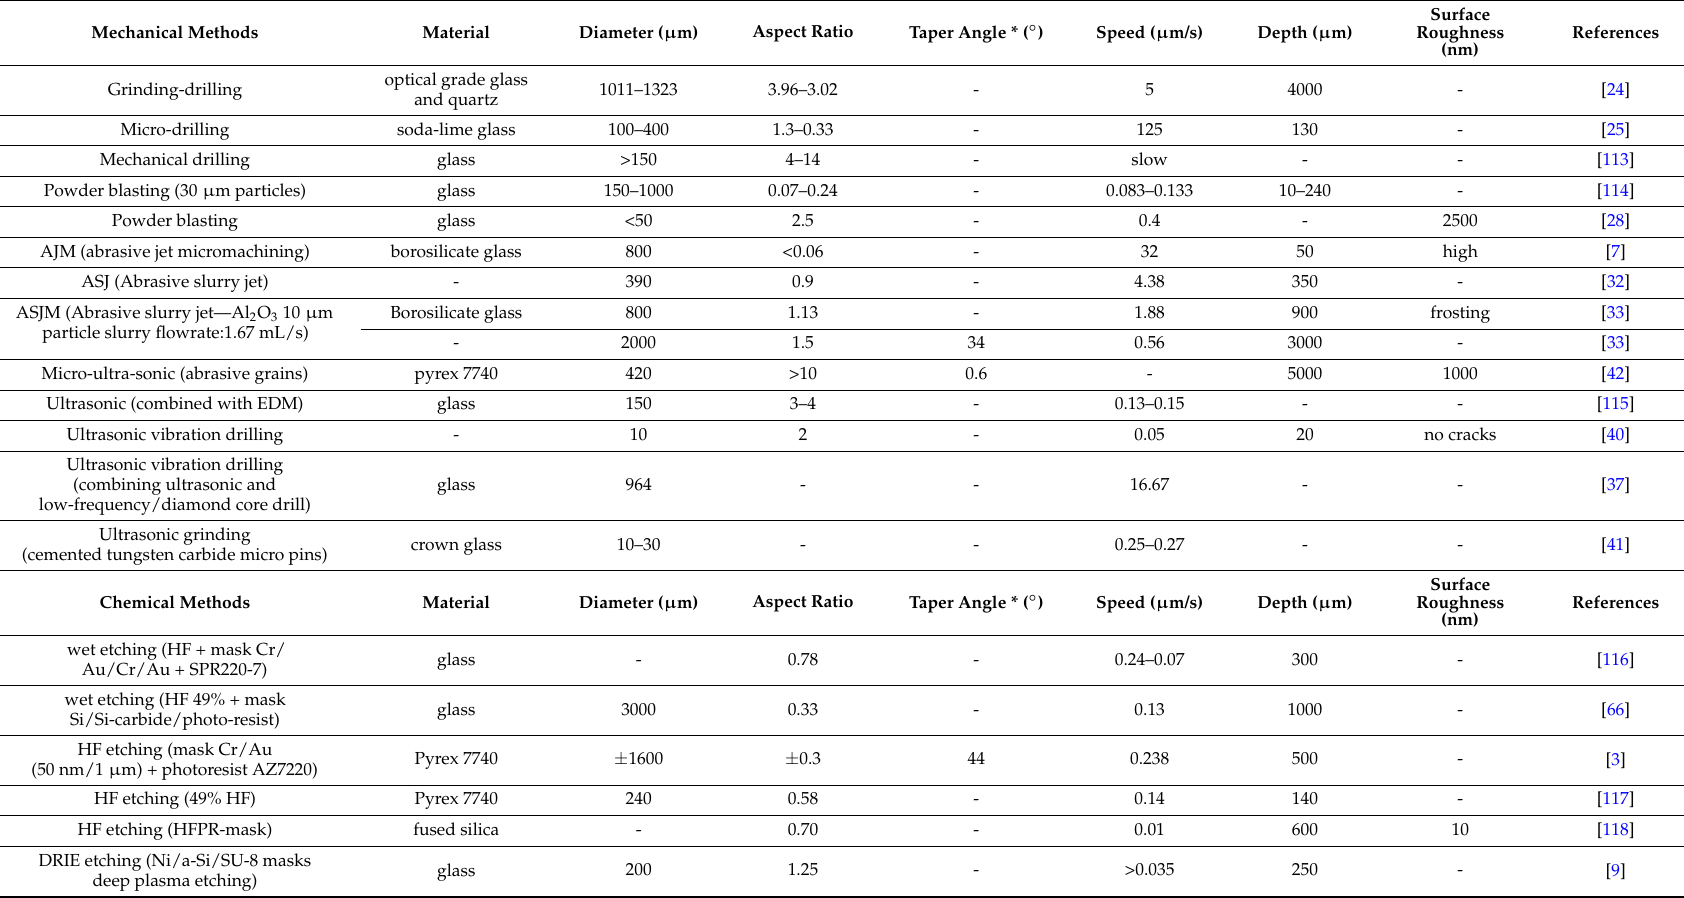
Table A1. List of different drilling techniques with their main feature characteristics for drilling micro-holes in